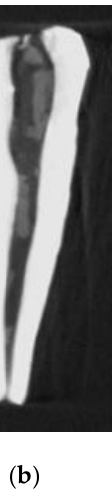
Figure 2. ( a ) Mandibular right central primary incisor, exfoliated at the age of 4 years and 1 month. ( b ) micro-CT analysis of the exfoliated tooth.